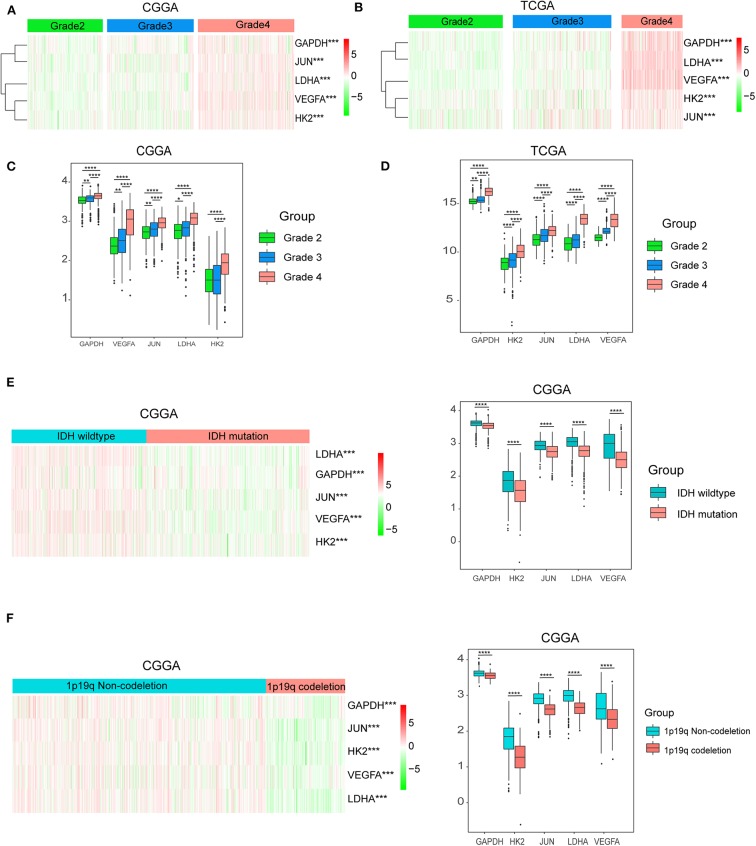
Hypoxia gene expression is correlated with clinicopathological features of gliomas. (A,B) Heatmaps showing five hypoxia gene expression profiles in different WHO grades from the CGGA and TCGA databases; (C,D) The expression levels of five hypoxia genes in gliomas with different WHO grades; (E) The expression levels of five hypoxia genes in gliomas with different IDH status; (F) The expression levels of five hypoxia genes in gliomas with different 1p/19q codeletion status; *P < 0.05, **P < 0.01, ***P < 0.001, and ****P < 0.0001.